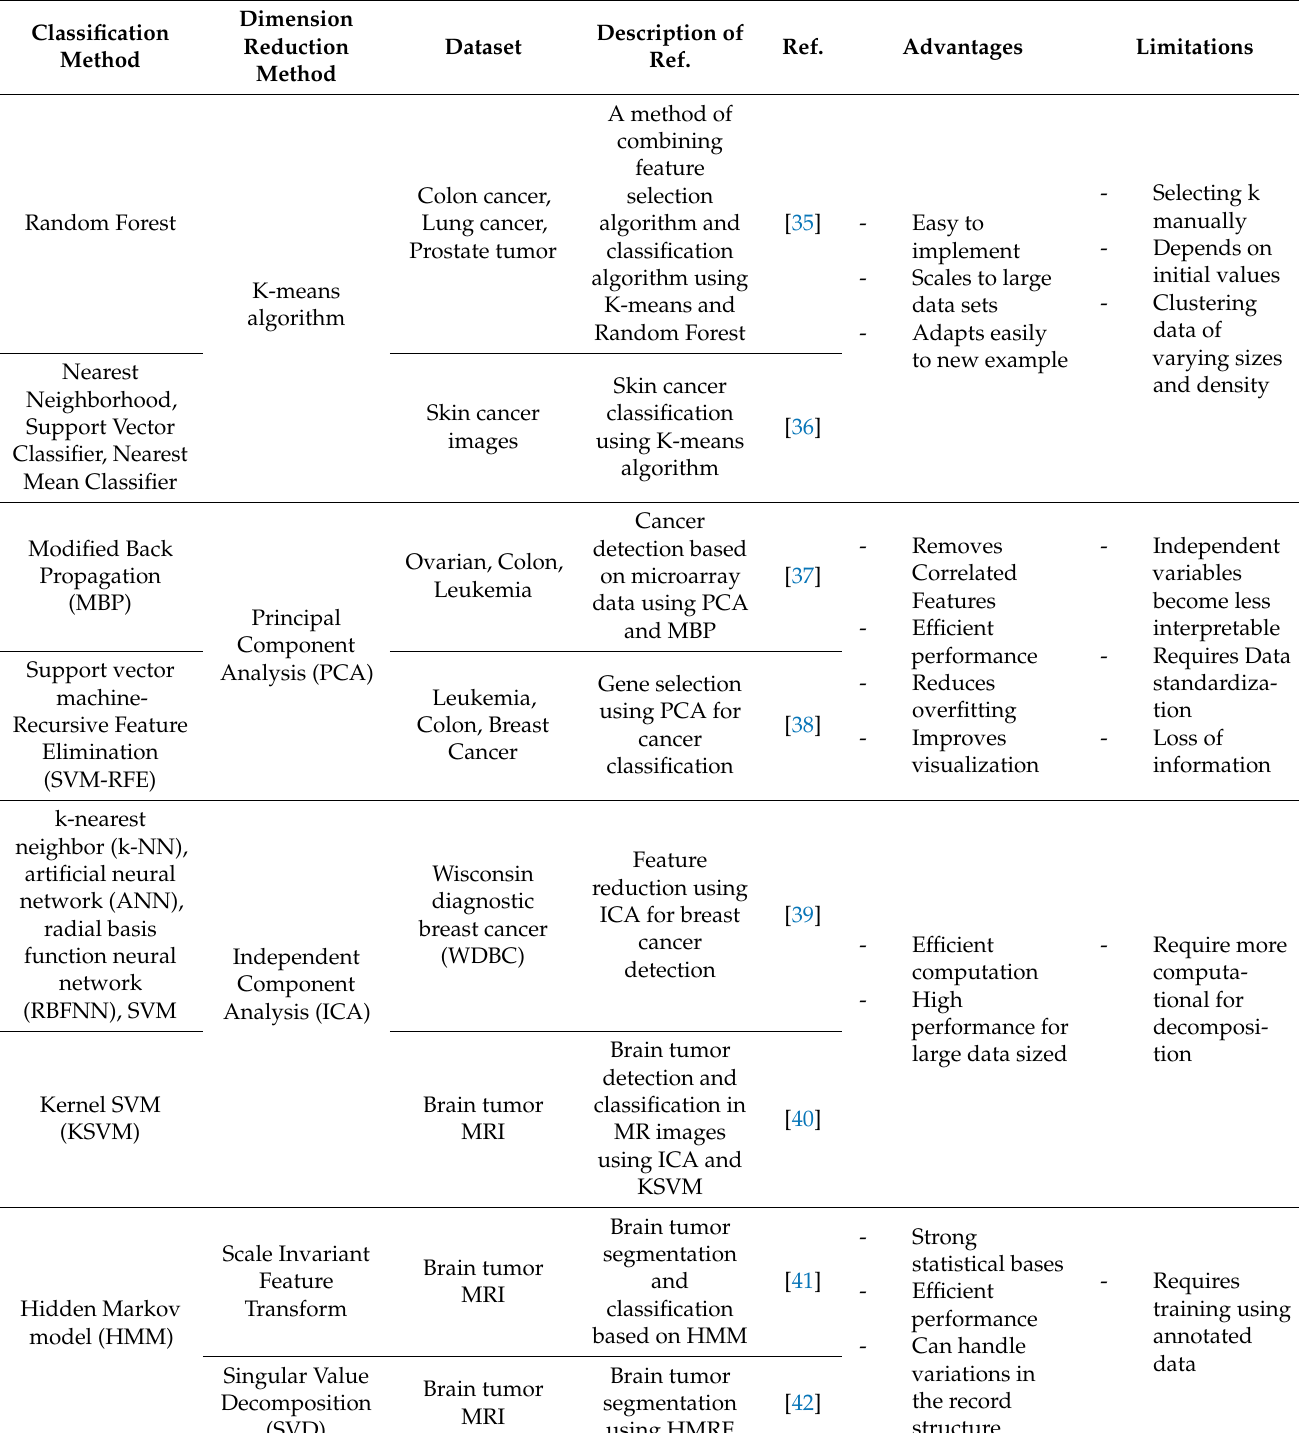
Table 2. Hybrid of supervised learning and unsupervised learning